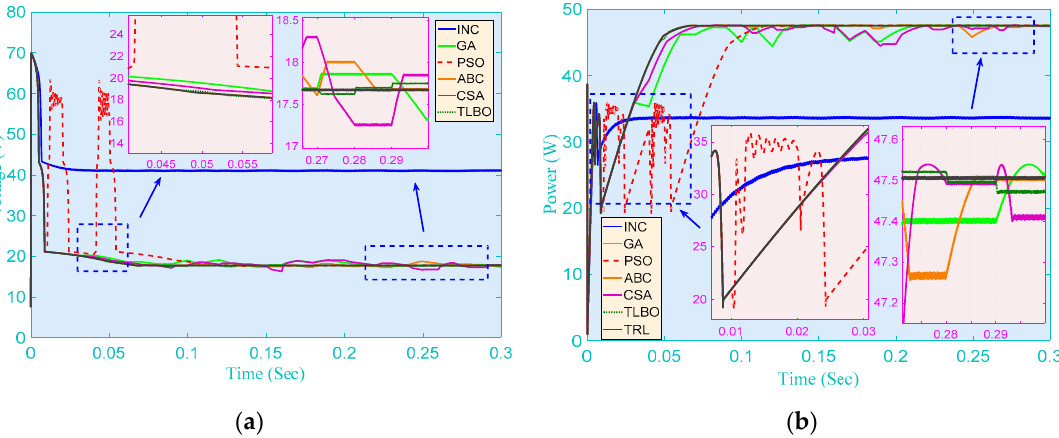
Figure 5. PV system responses of seven methods obtained on the start-up test. ( a ) Voltage; ( b ) Power.